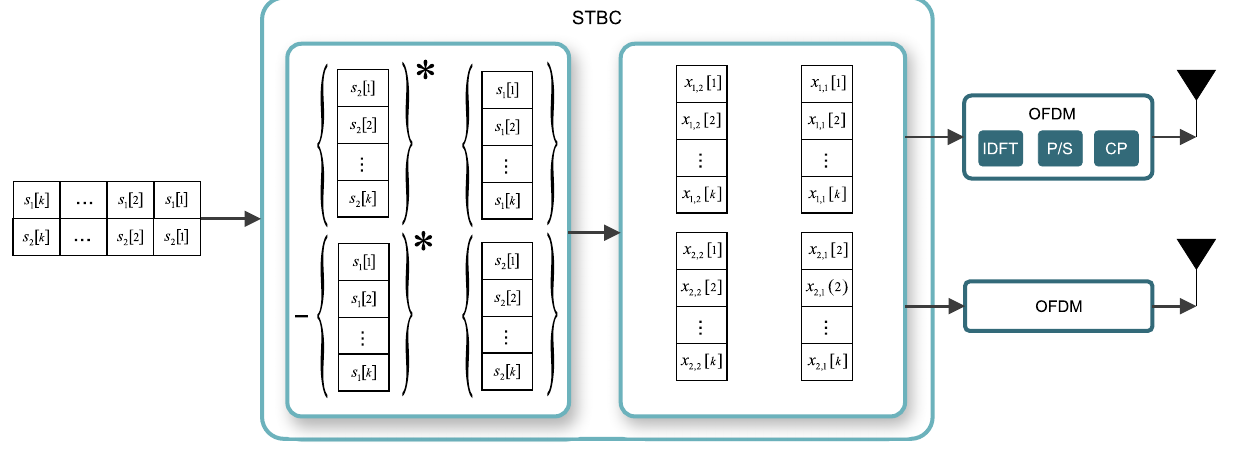
Figure 2. Detailed MIMO-OFDM coding system. {·} ∗ denotes the conjugate